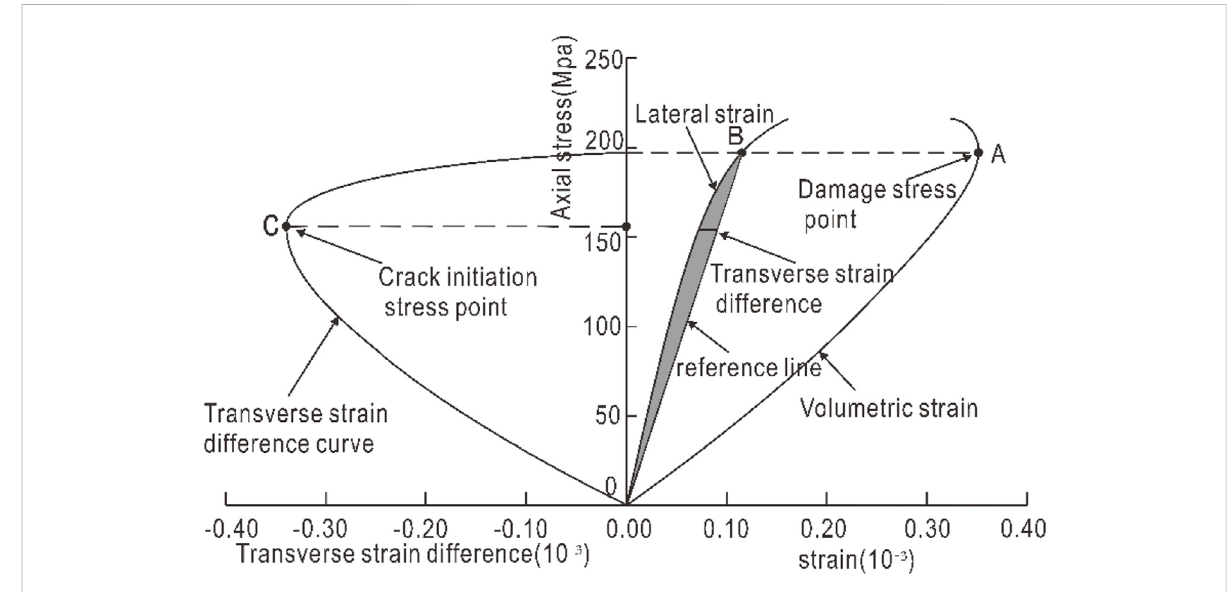
FIGURE 4 Schematic diagram of transverse strain response method (Nicksiar and Martin, 2012)